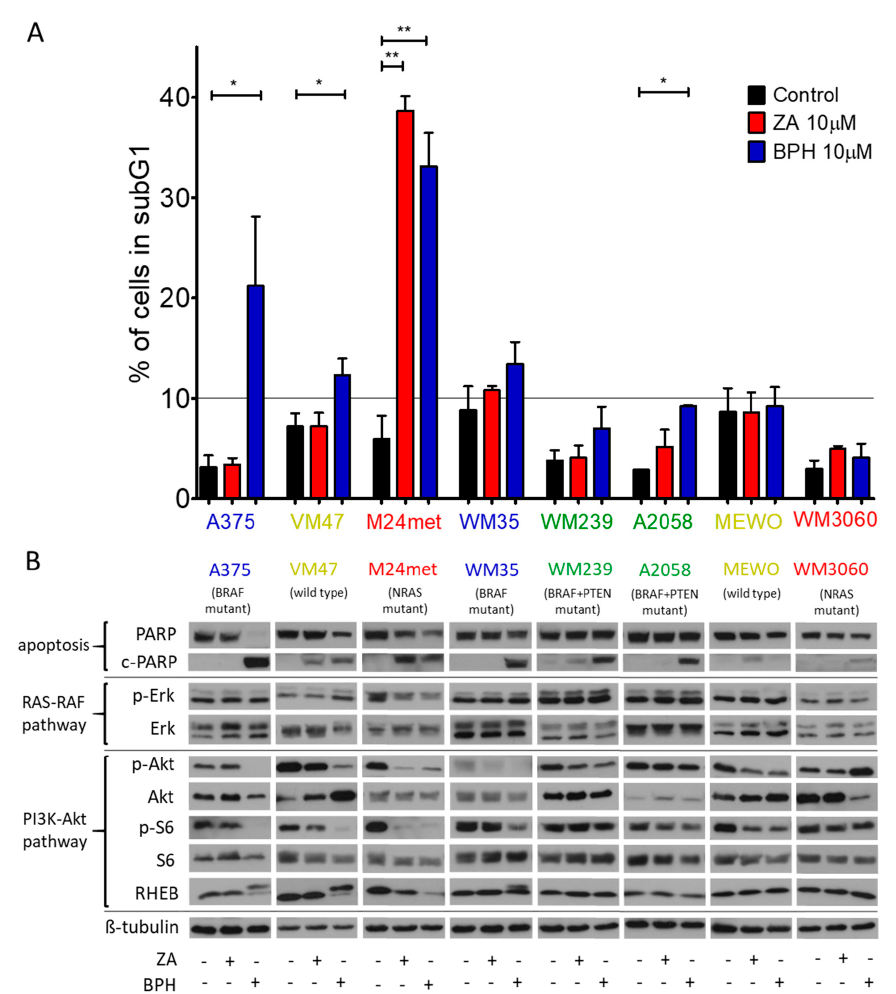
Figure 3. ( A ) The cell cycle distribution was examined after 72 h of treatment with 10 µ M ZA or BPH. In most cell lines, BPH increased more strongly the ratio of cells in the subG1 phase except for the M24met cell line. Data are shown as the average ± SD from two or three measurements. Asterisks mean a significant difference between the control and treated groups by * p < 0.05 and ** p < 0.01. ( B ) Western blot analysis was performed to detect the apoptosis induction and protein activation after 48 h-long treatment with 10 µ M ZA or BPH. C-PARP was detected in most of the cell lines, particularly after treatment with BPH. Levels of total and phosphorylated Akt, S6, and Erk, as well as Rheb and c-PARP / PARP protein were analyzed. β -tubulin was used as the loading control. In the majority of the cell lines, activation of S6 and / or Akt decreased especially after BPH treatment, while Erk activation did not change substantially. The Rheb protein level was modified by BPH treatment in four cell lines (A375, WM35, VM47, M24met). Immunoblots are representative images from at least three independent measurements. The colors of the cell names represent the mutational group of the cells as BRAF (blue), BRAF + PTEN (green), NRAS mutant (red), and BRAF + PTEN + NRAS wild-type